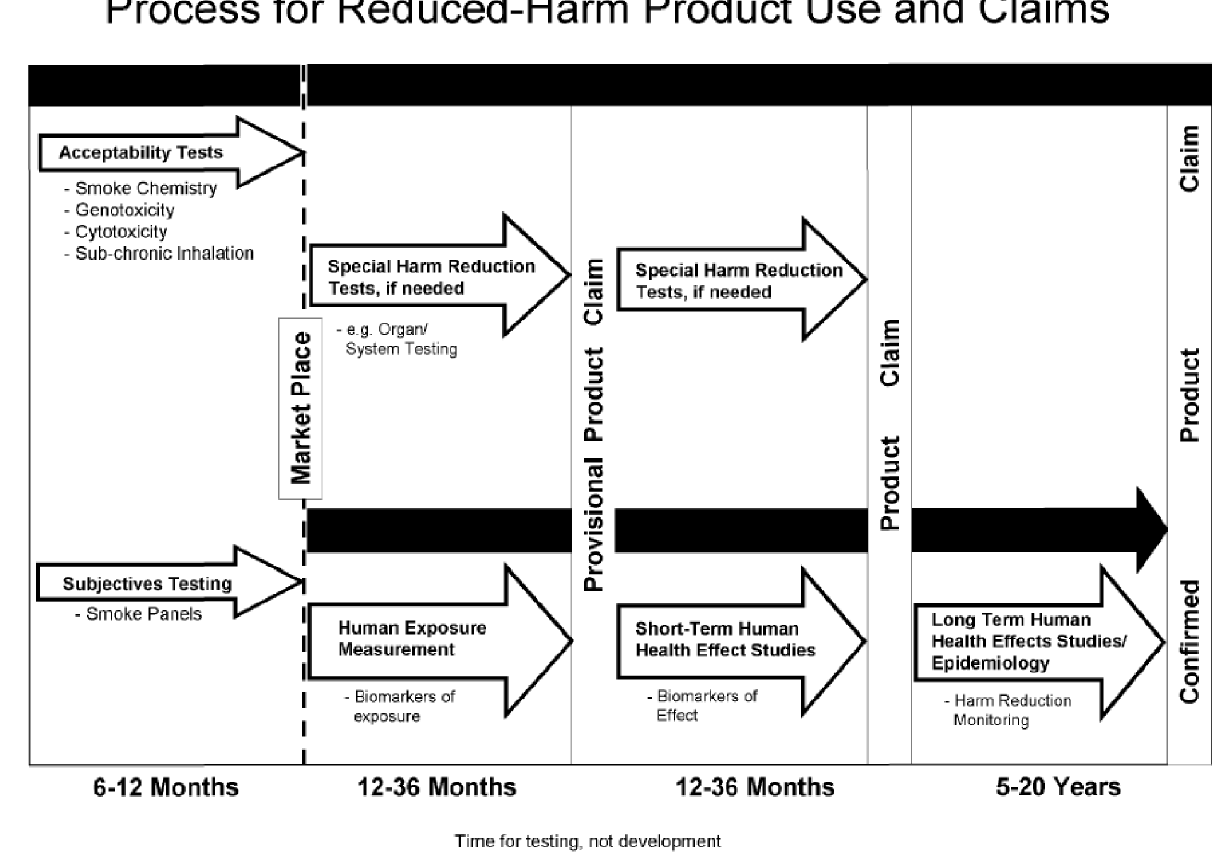
Figure 1. PM proposed timeline for assessment of reduced-harm products [219].